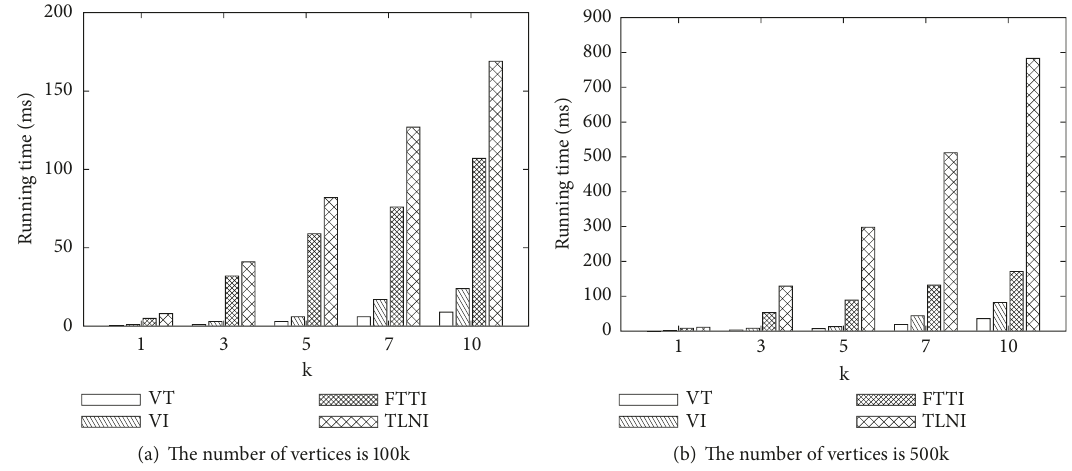
Figure 10: Impact of 𝑘